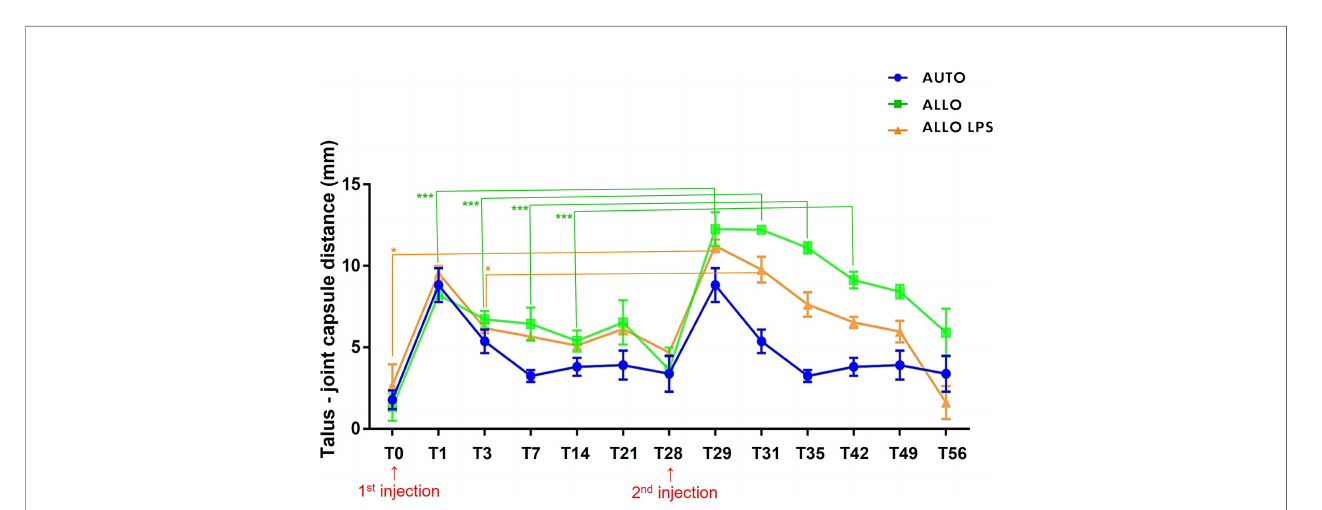
FIGURE 6 | Mean ± SD values of synovial effusion, measured by the distance between the talus and the joint capsule. ALLO group presented statistical differences between fi rst and second injection at T0, T1, T3, T7 and T14 (***P<0.005), whereas ALLO LPS group showed differences between fi rst and second injection comparing T0 to T28 and T3 to T31 (*P<0.05).